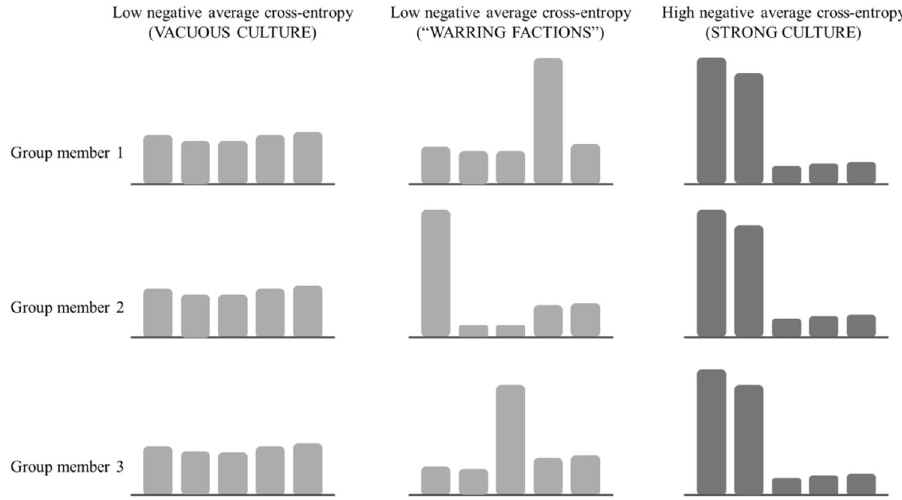
Fig. 1 Examples of cultural strength based on the negative average cross-entropy metric. In Fig. 1, we describe an organizational culture based on the relative levels of negative average cross-entropy displayed by its members ’ distribution of mindshare over cultural attributes and identify three possible culture typologies